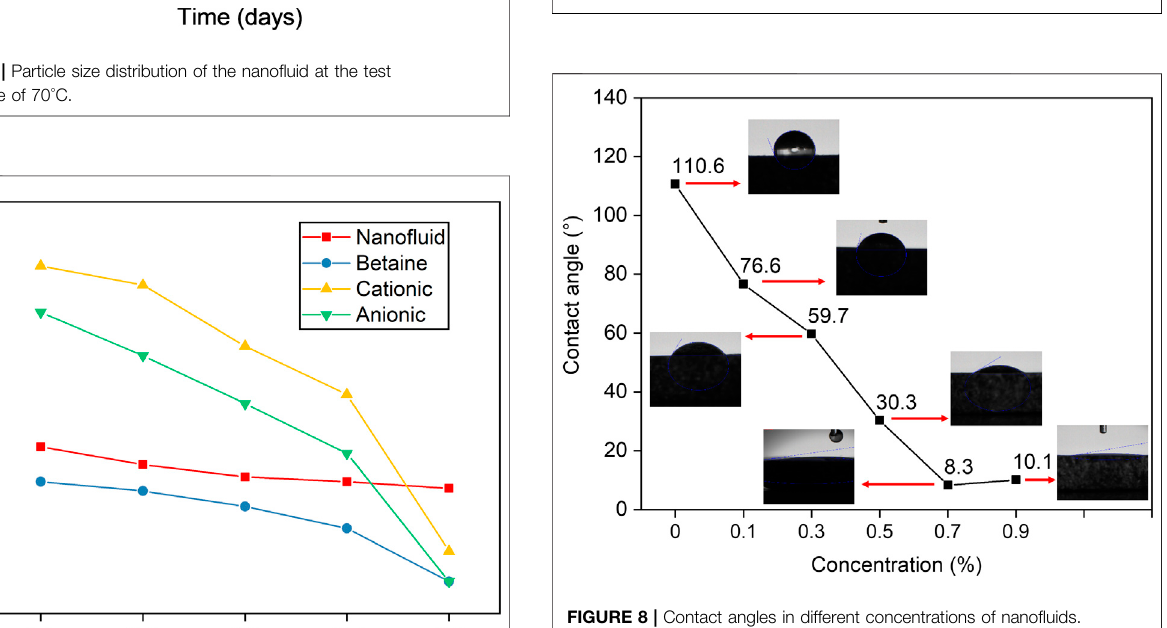
FIGURE 7 | Contact angle before and after oil displacement agent treatment.